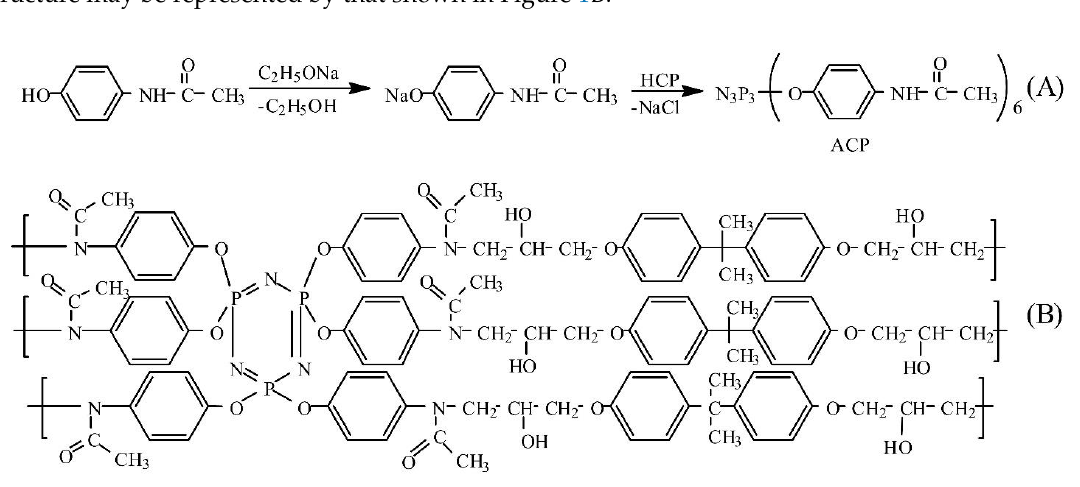
Figure 1. Synthesis of hexakis(4-acetamidophenoxy)cyclotriphosphazene (ACP) ( A ) and a proposed structure of the cured epoxy resin ( B ).